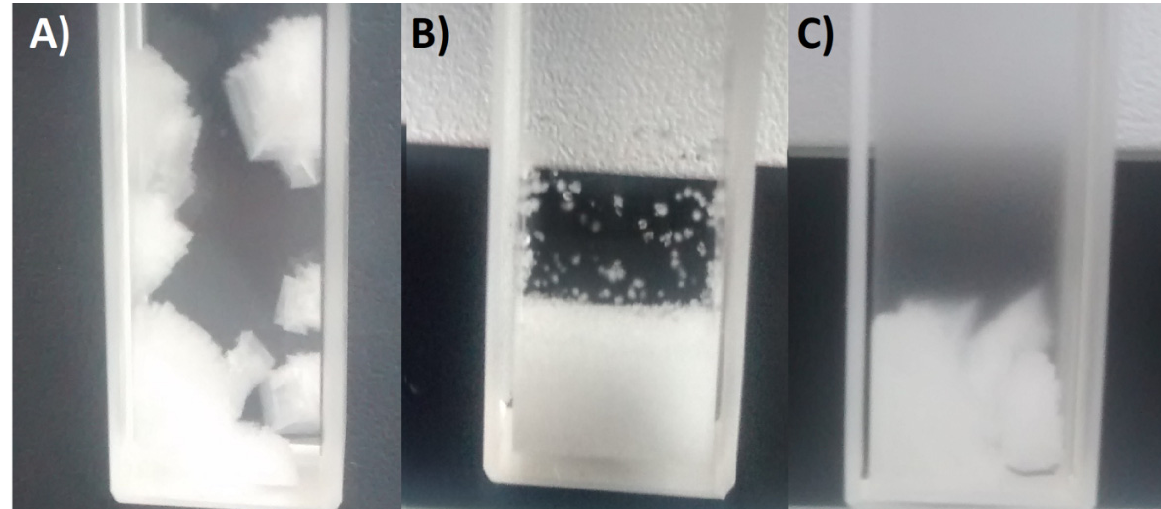
Figure 2. KCL crystals from 30% w / w solution: ( A ) Solution without any additives, no mixing during cooling; ( B ) solution without any additives, 1000 RPM mixing; ( C ) solution with 0.25% w / w PAA, no mixing during cooling.